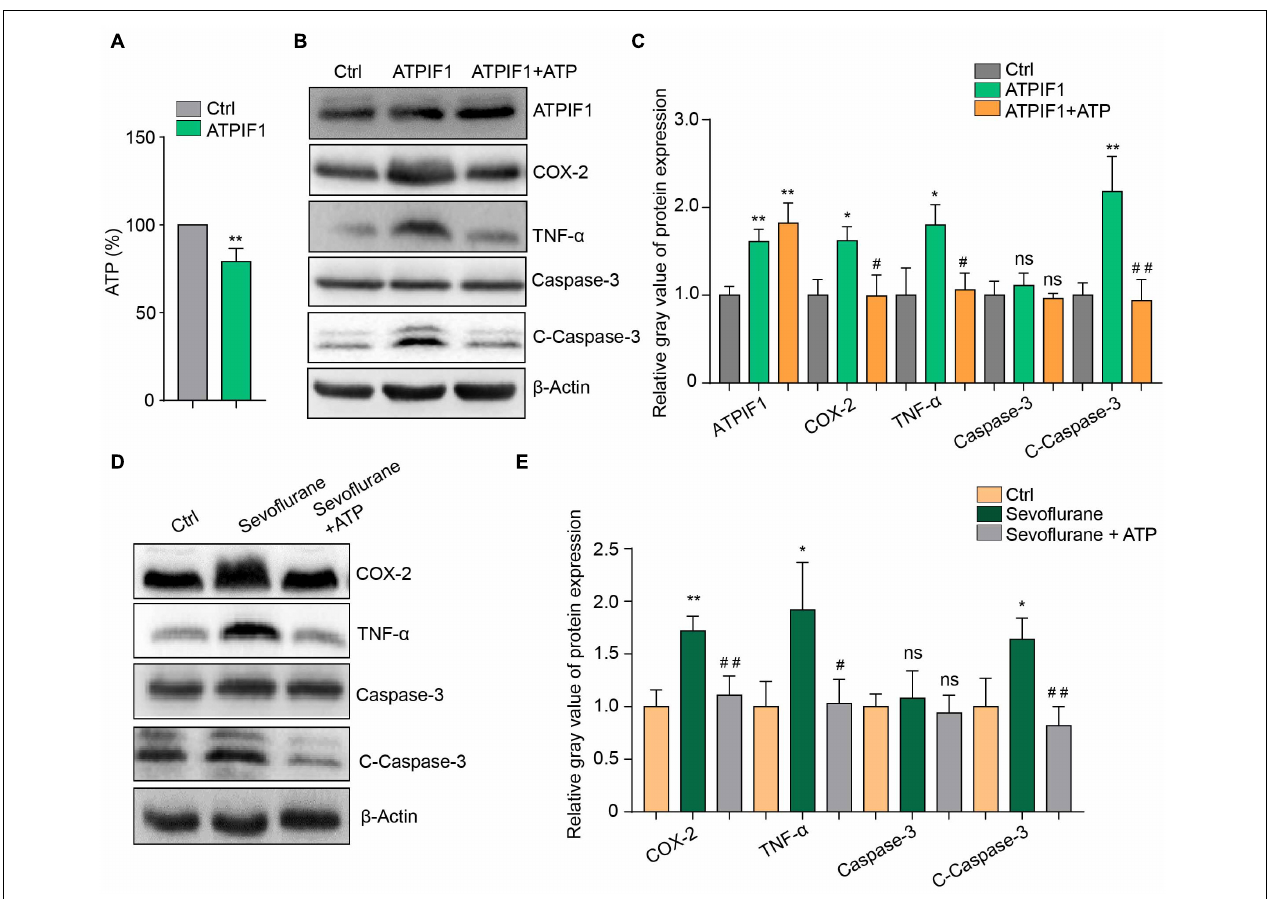
FIGURE 3 | Additional ATP supplementation ameliorated ATPIF1- or sevoflurane-induced inflammation and caspase-3 activation in BV2 cells. (A) Overexpression of ATPIF1 decreased the intracellular ATP concentrations in BV2 cells. (B) ATP (50 µ g/ml) ameliorated the ATPIF1 overexpression induced inflammation and caspase-3 activation in BV2 microglia. (C) Statistics of the relative gray value indicating the protein expression in panel (B) . (D) ATP also ameliorated sevoflurane treatment- induced inflammation and caspase-3 activation in BV2 microglia. (E) Statistics of the relative gray value indicating the protein expression in panel (D) . Ctrl means control. β -Actin served as a loading control. One-way ANOVA with repeated measurement were used to determine differences in panels (C,E) . The data shown are the means ± SD, n = 3, * or # means p < 0.05, ** or ## means p < 0.01. ns means no significant